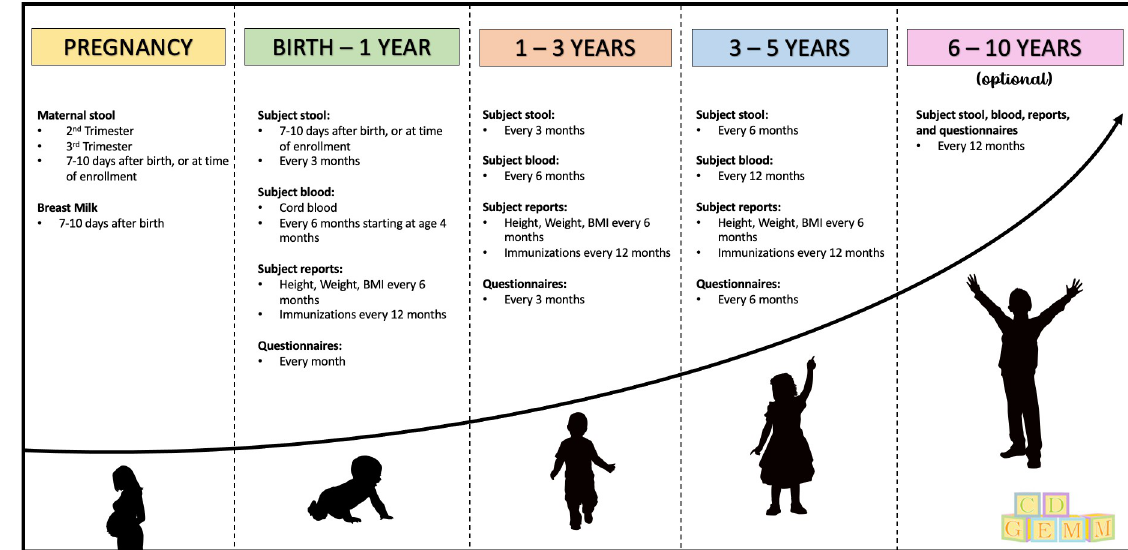
Fig 1. Study timeline. Samples and data collected and their frequency are